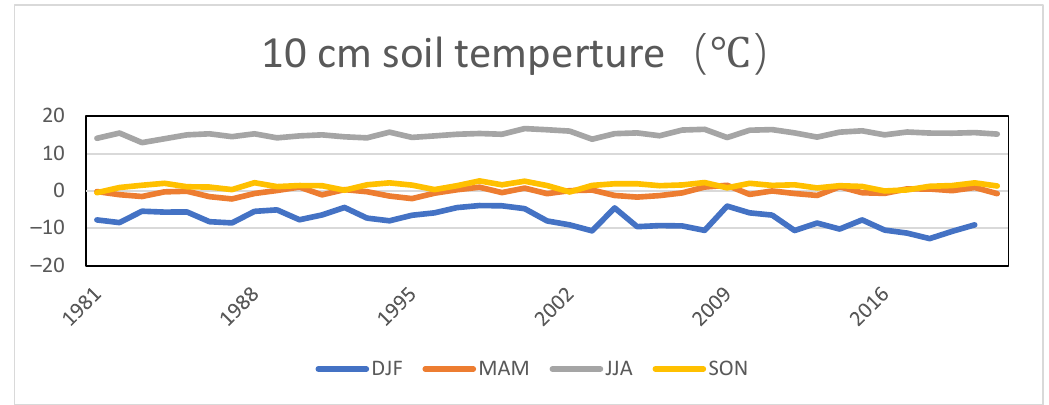
Figure 6. Yearly change of seasonal surface soil temperature.